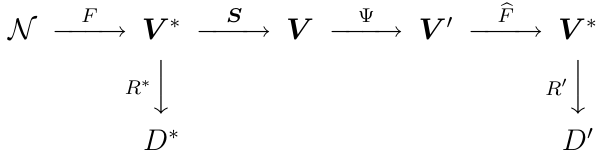
Figure 1. A WSN as a sampling/reconstruction